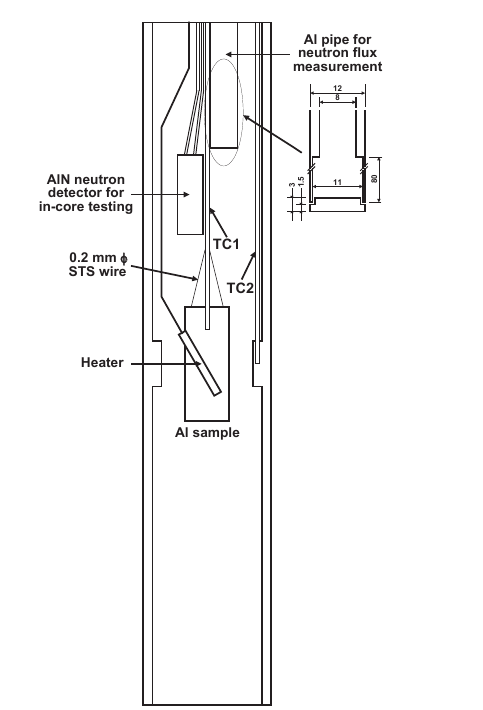
Fig. 2. Detailed layout of the sensor part of calorimeter.